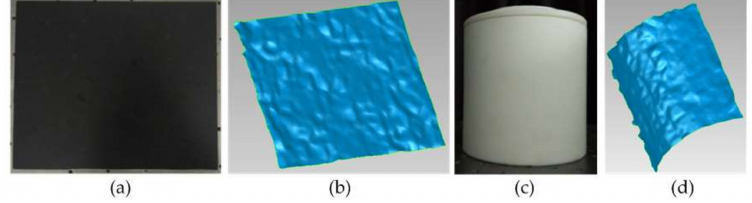
Figure 11. Standard plate ( a ) and column ( c ). The 3D point cloud of plate working surface ( b ) and column working surface ( d ).